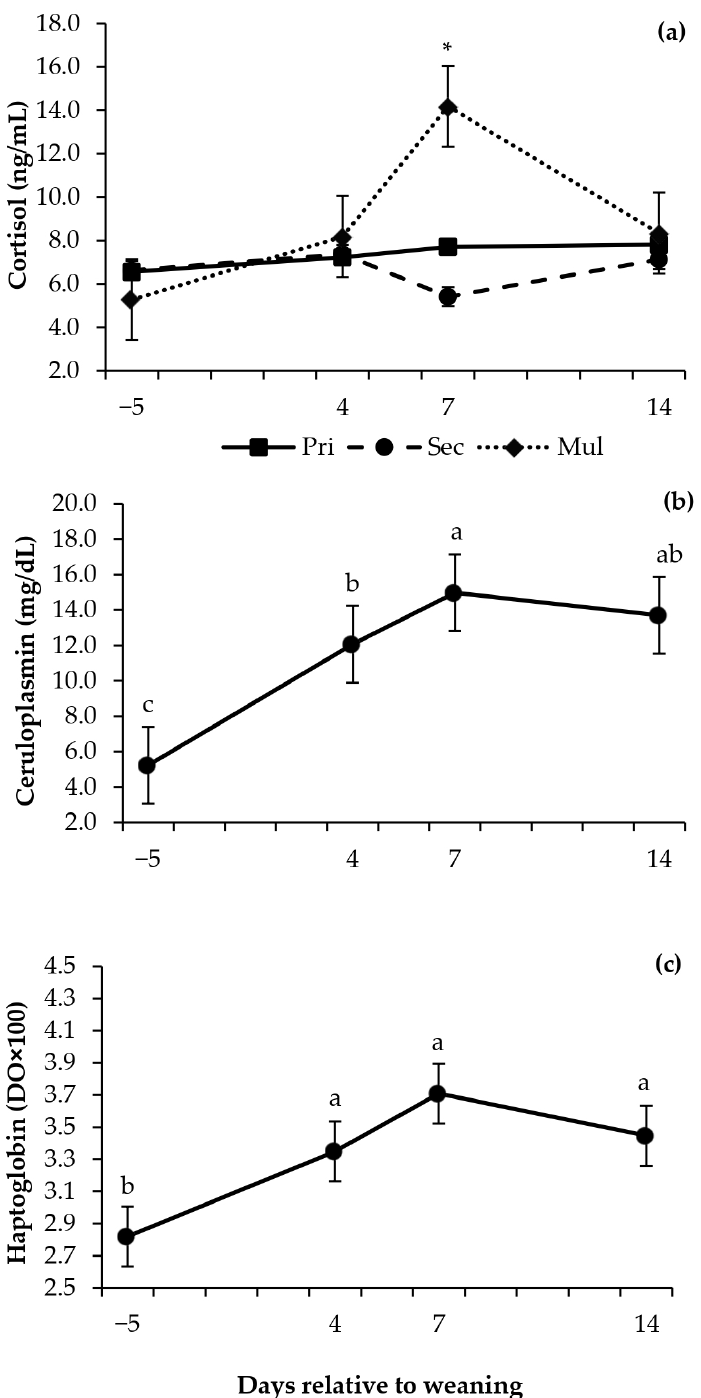
Figure 2. Cortisol ( a ), ceruloplasmin ( b ), and haptoglobin ( c ) serum concentrations in Nellore cows with different parity under grazing according to the days relative to weaning. Days with different superscripts differ from each other for all parity orders ( p < 0.05). On days with asterisks (*), there is a parity × day interaction ( p < 0.05). Table 2. E ff ect of parity on physiological measurements in Nellore cows at abrupt weaning. p- Value Parity SEM